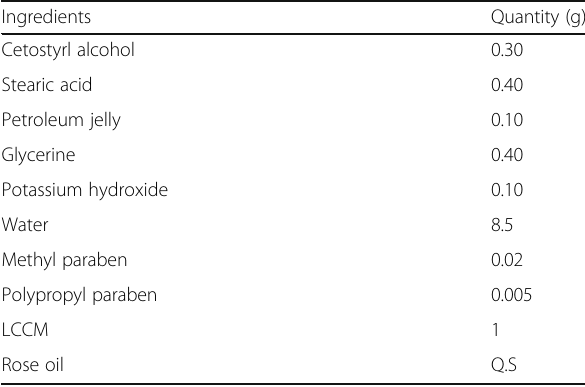
Table 1 Composition of